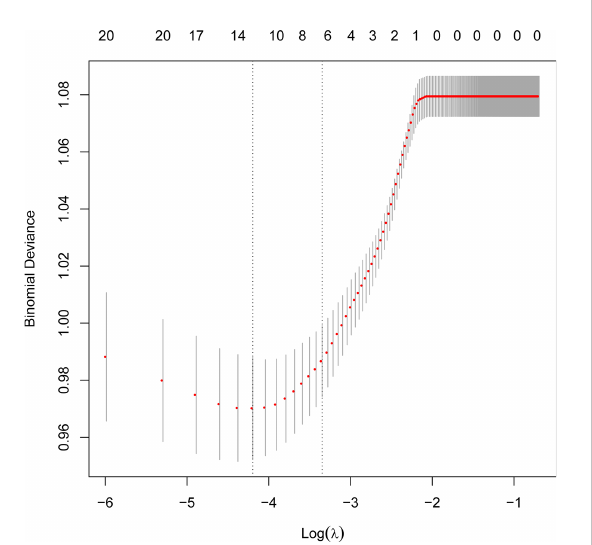
FIGURE 2 Perioperative variables selection using the Least Absolute Shrinkage and Selection Operator (LASSO) regression.